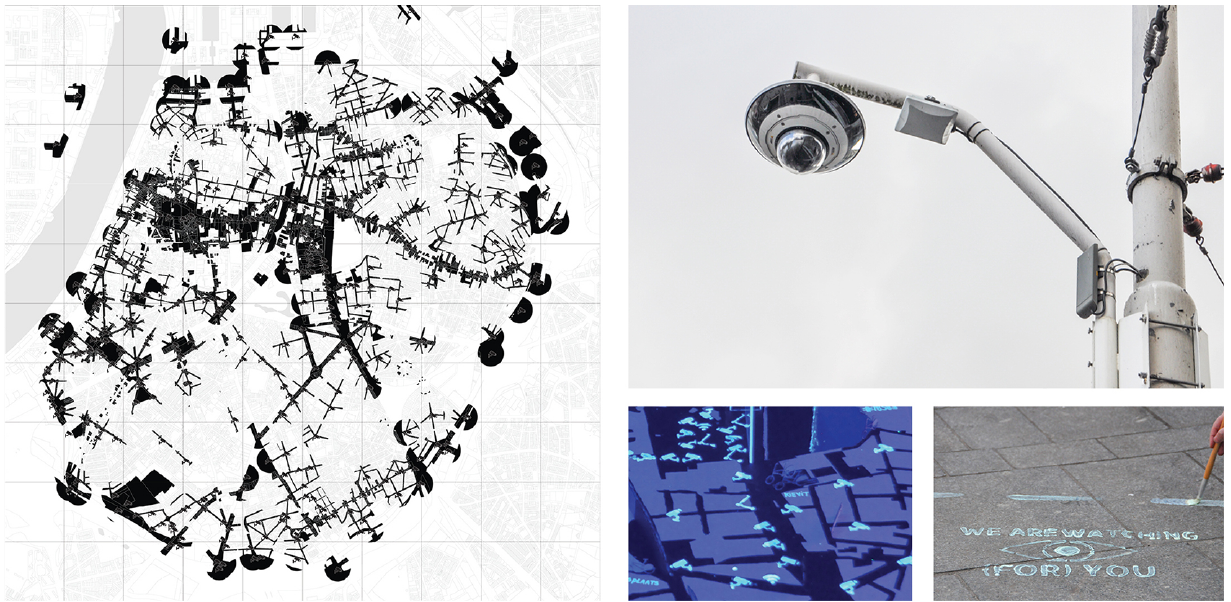
Figure 6. Surveillance. Left: Map—‘Watching’ (for) you (the map covers the large majority of surveillance cameras within the public domain that were detected during the workshop. There might possibly be more). Above right: Image of spaces controlled by surveillance cameras in the centre of Antwerp. Below right, from left: Depiction of cameras visible under UV-lights in the ‘Analogue City’ map; street painting marking the data point of the map. Source: The ‘Analogue city,’ IDW University of Antwerp 2019 students, and the